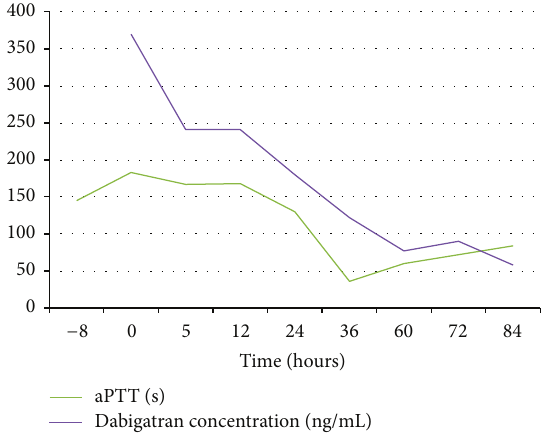
Figure 1: aPTT and dabigatran plasma concentration versus time after